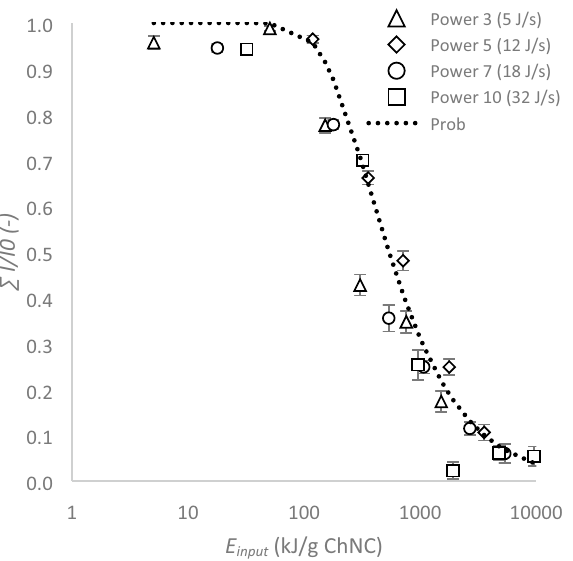
Figure 4. Normalized total intensity as function of ultrasound energy ( E input ) in kJ/g chitin nanocrystals determined via static light